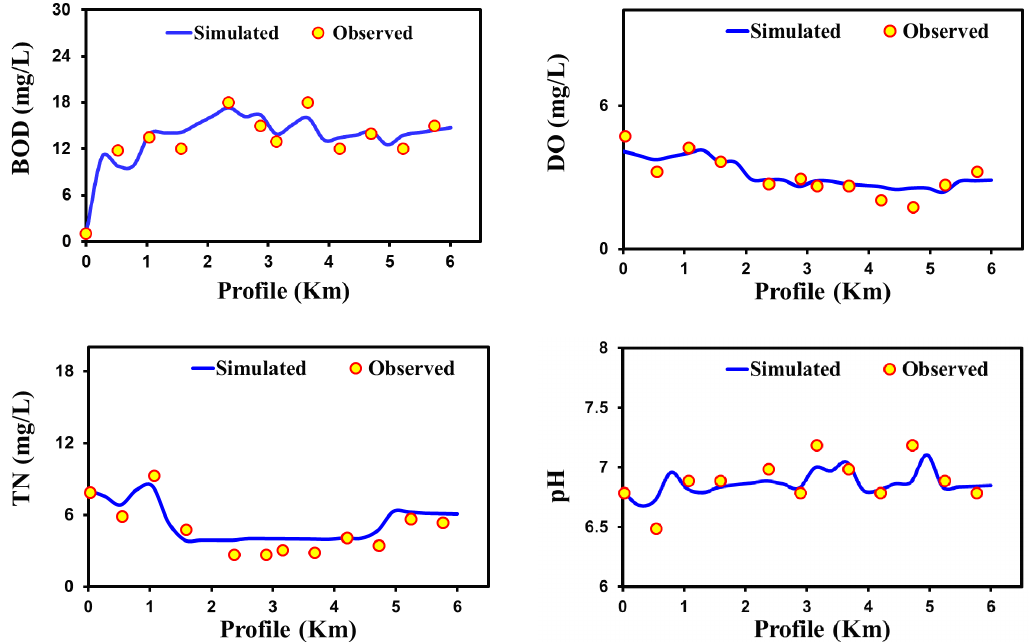
Figure 5. Confirmation of water quality model results in Galing River (tropical climatic region) for BOD, DO, TN, and pH.